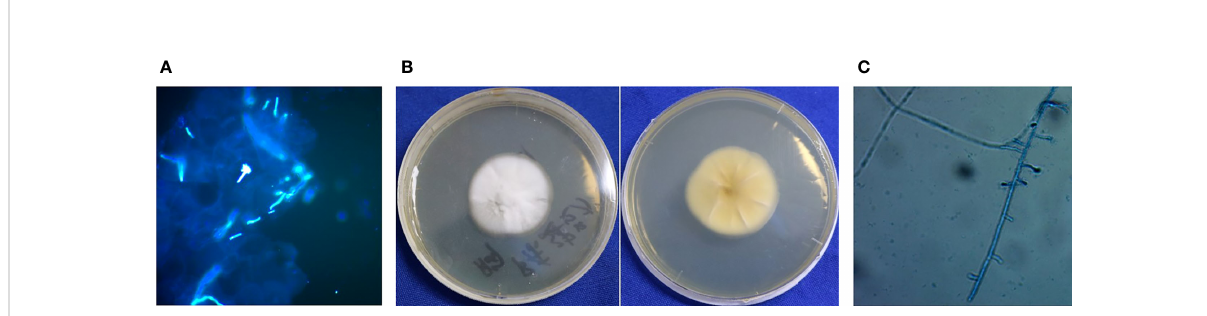
FIGURE 3 Resultsof etiological examination. (A) Direct fl uorescenceofmultipleskinlesionswerepositive forpseudohyphae(Magni fi cation:40×). (B) Macroscopic appearanceof T. tonsurans : white, villiformcolony on SDAafter7dofincubationat28°C. (C) Microscopicexaminationofthe morphologyof mycelium.